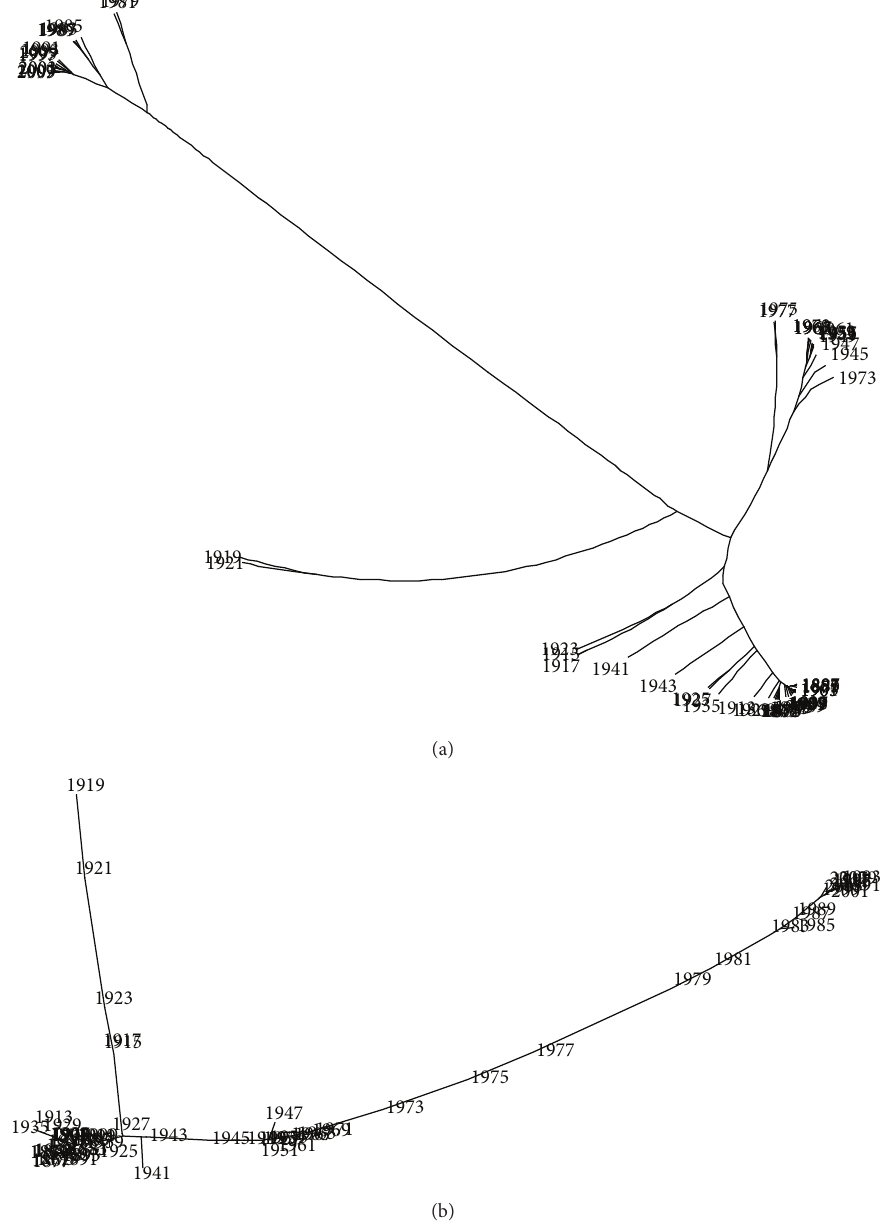
Figure 14: Trees of the Portuguese economic evolution, in the perspective of the Cosine correlation 𝑟 𝐶 , 𝑇 = 1865 – 2010 , ℎ = 2 years, methods “kitsch” and “fitch” (option